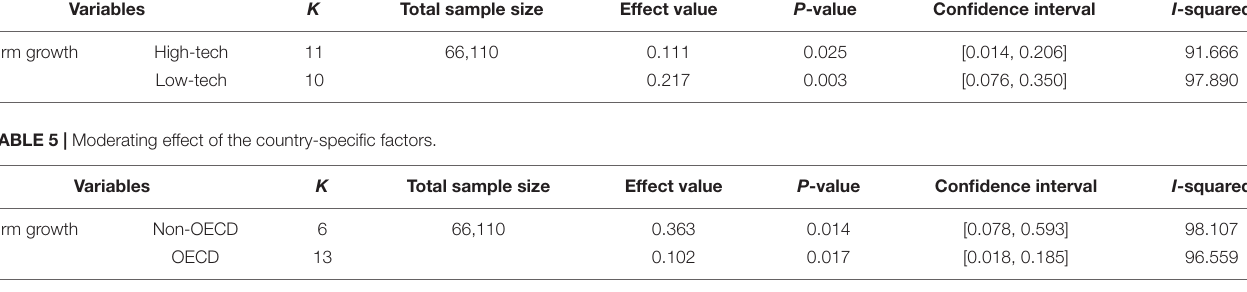
TABLE 6 | Moderating effect of the performance time